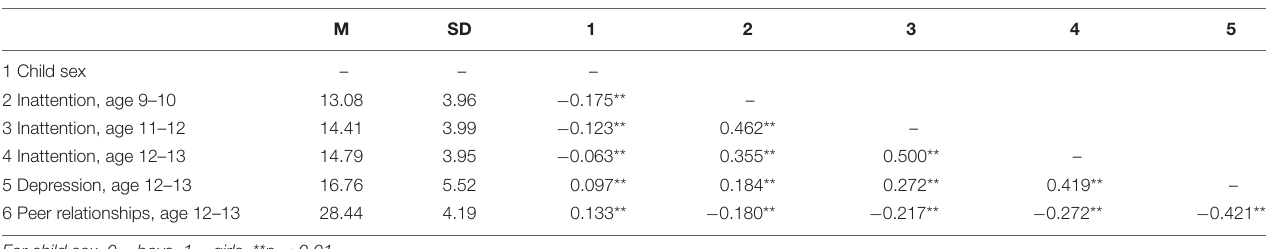
TABLE 1 | Descriptive statistics and bivariate correlations (Panel 1).